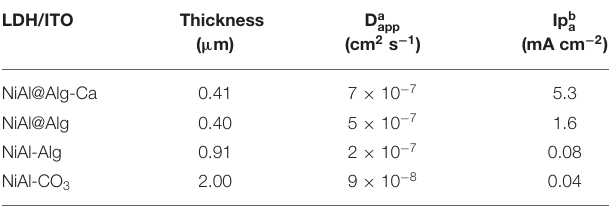
TABLE 2 | Characterization of the NiAl LDH/ITO modified